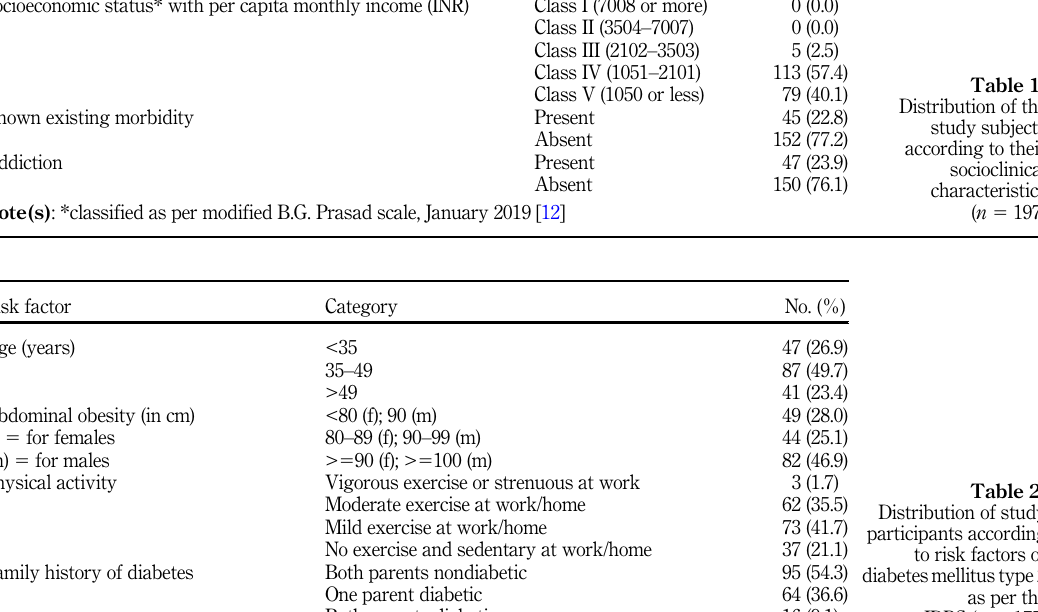
Table 1. Distribution of the